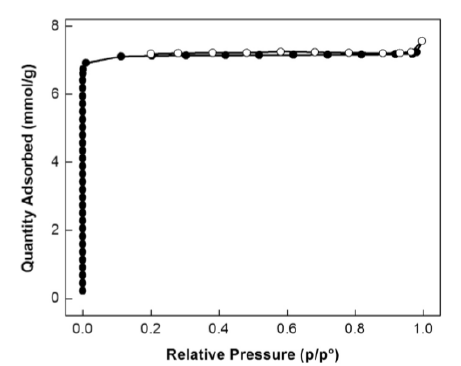
Figure 9. N 2 adsorption-desorption isotherm. Full circles - adsorption, empty circles - desorption.